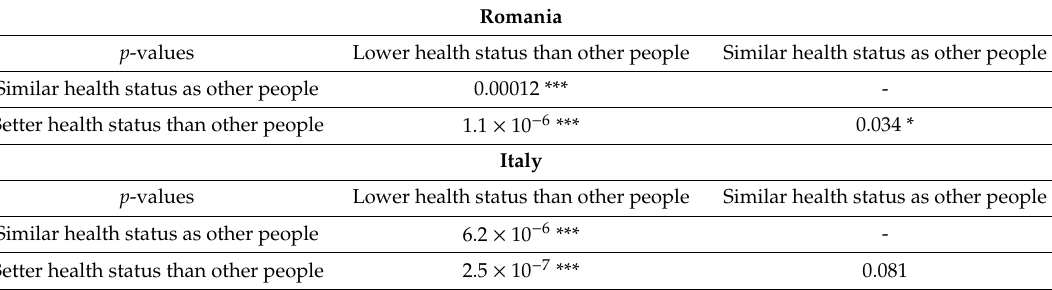
Table 9. Post–hoc test for health status: Optimism index